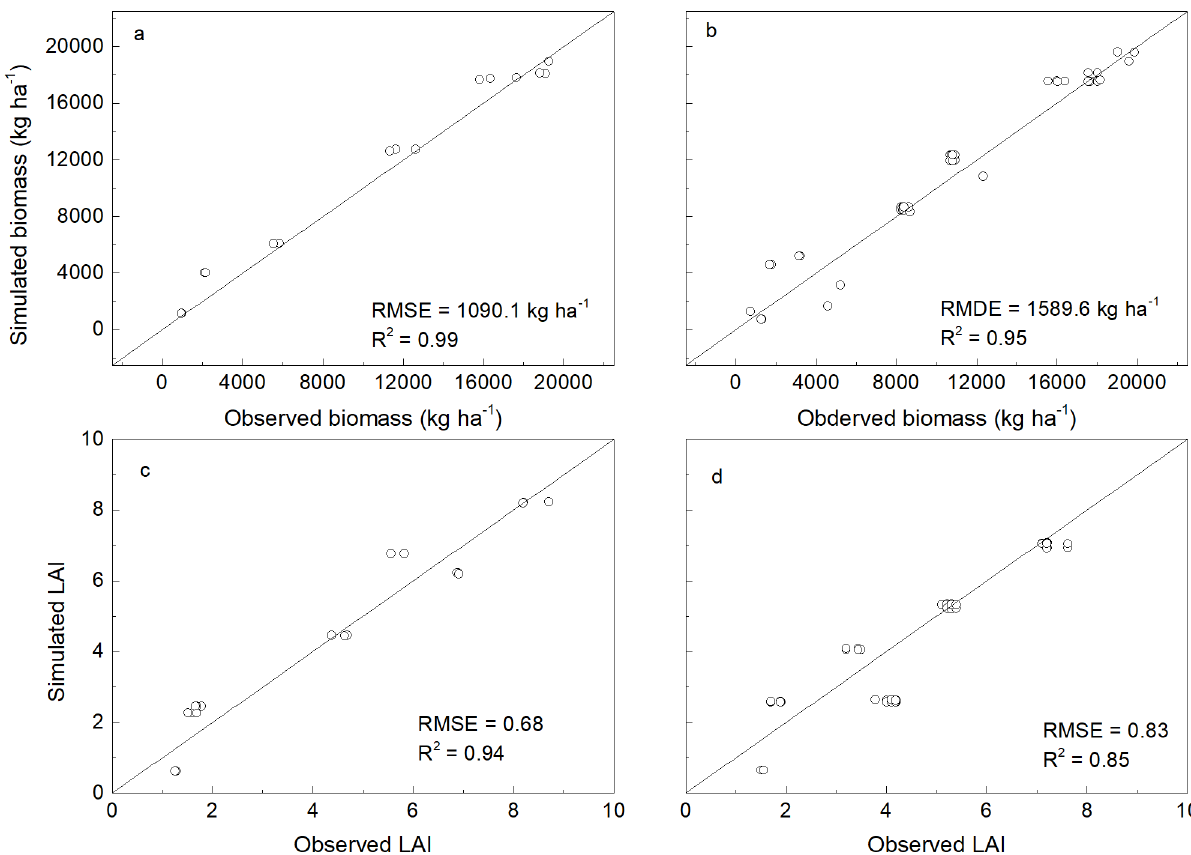
Fig 2. Comparisons of measured and observed above-ground biomass (a for 2013–2014 and b for 2014–2015) and LAI (c for 2013–2014 and d for 2014–2015). a and c were used to calibrate the model, b and d were used to validate the model.